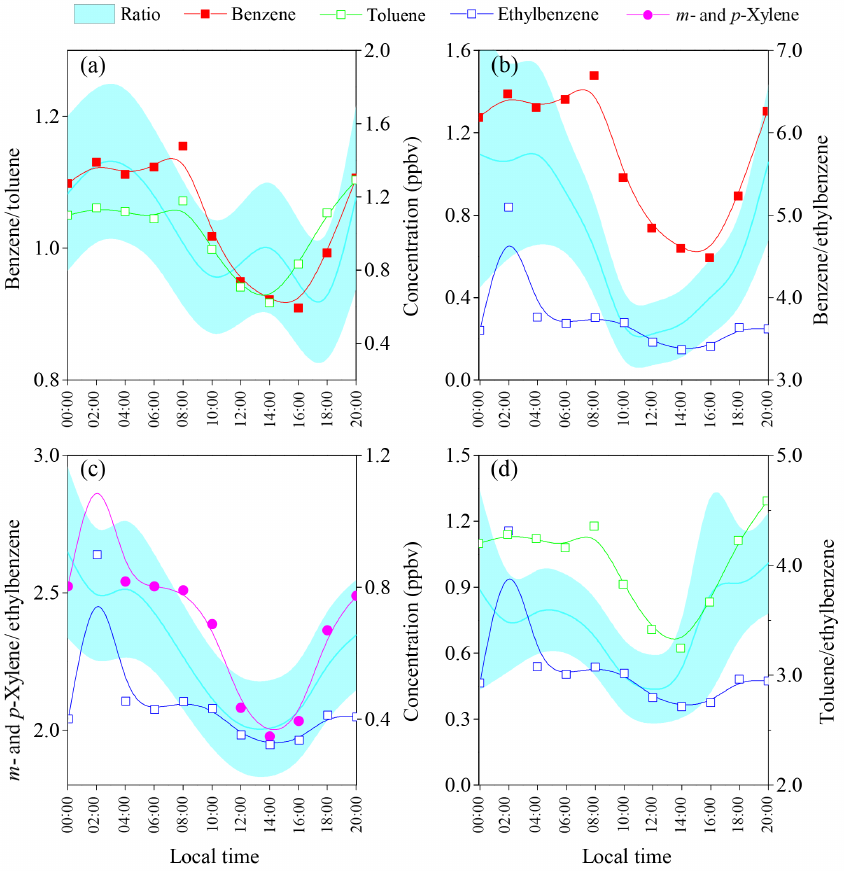
Figure 9. Diurnal variations in benzene, toluene, ethylbenzene, and m - and p -xylene and their ratios: benzene / toluene (a) , ben- zene / ethylbenzene (b) , m - and p -xylene / ethylbenzene (c) , and toluene / ethylbenzene (d)